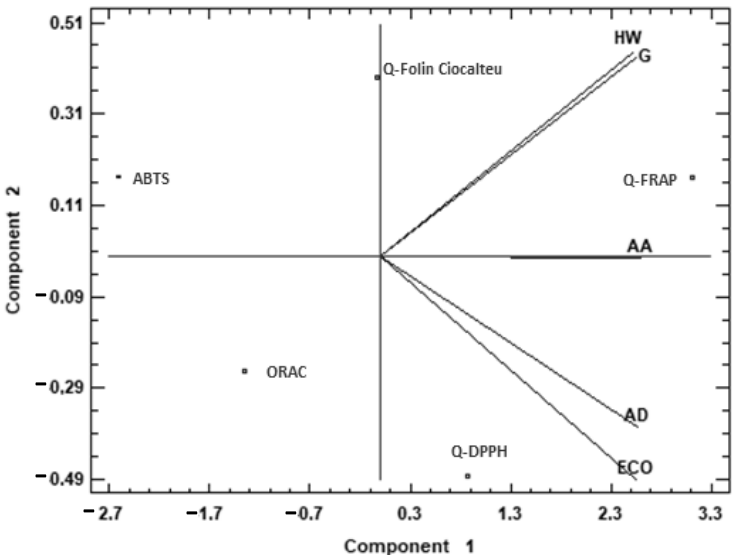
Figure 1. Principal component analysis (PCA) projection of two principal components on antioxidant capacity. Sample letters: AD: A. deliciosa ; HW: A. deliciosa var. Hayward; ECO: A. deliciosa var Hayard eco; G: A. chinensis ; AA: A. arguta .